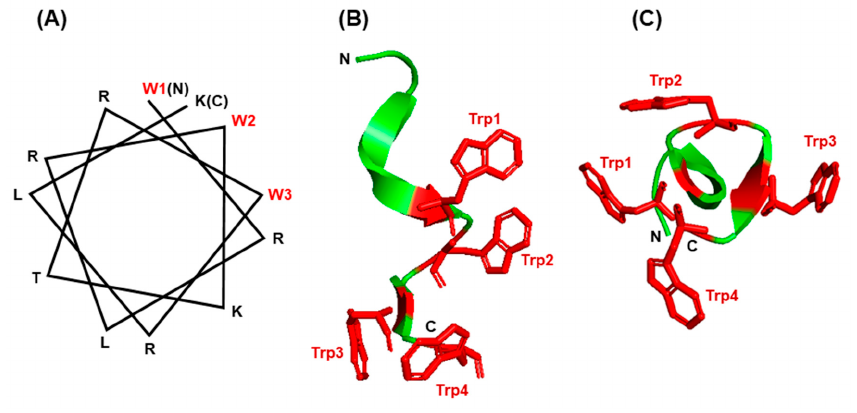
Figure 7. Structure of small Trp-containing peptides. ( A ) Helical wheel presentation of peptide WRK-12 (WRLRWKTRWRLK) and ( B , C ) three-dimensional structures of gramicidin A (PBD 1C4D) in PyMol ribbon presentation are shown. All Trp (W) residues are indicated in red. For gramicidin, two views of the Trp-containing portion of the peptide are presented: a side view ( B ) and a top view of the cylinder shape ( C ), showing the Trp side chains protruded around the channel. The amino- and carboxy-termini are indicated with N and C,